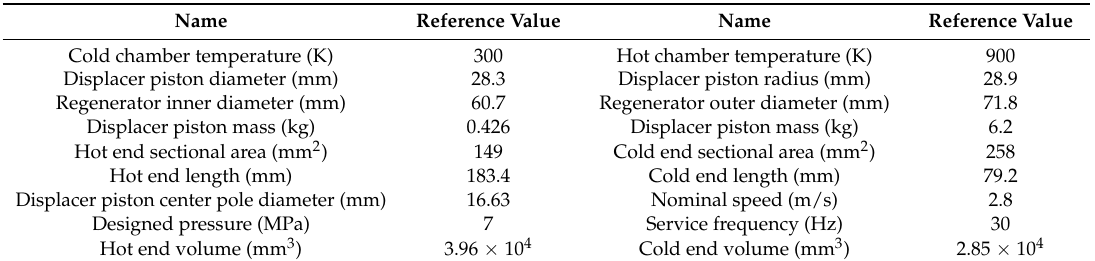
Table 1. Basic parameters of free-piston Stirling power generating system.